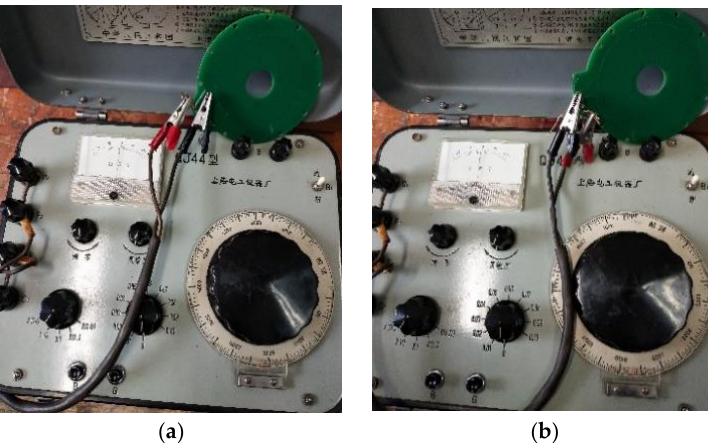
Figure 17. Resistance measurement; ( a ) resistance measurement of the distributed winding; ( b ) resistance measurement of the improved winding.